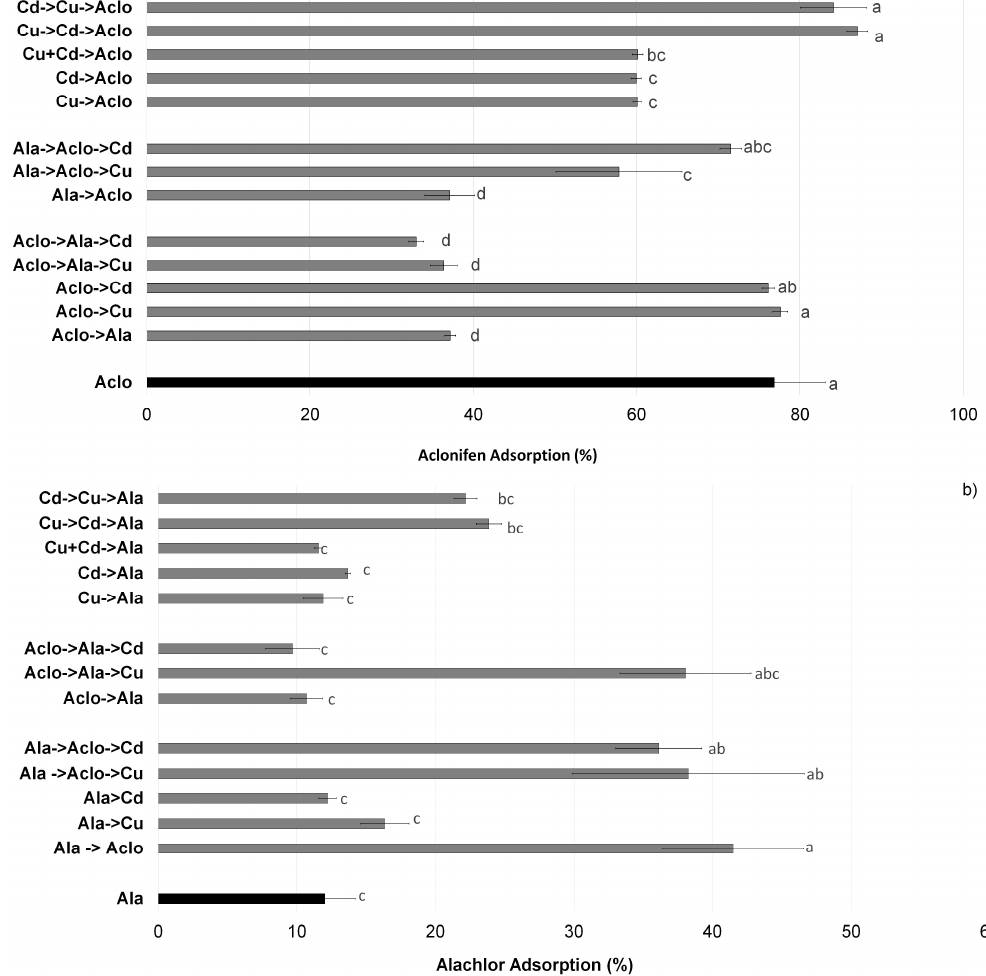
Figure 6. Average percentage of Aclonifen ( a ) and Alachlor ( b ) adsorbed on Suspended Matter in different multipollution scenarios. Means with the same letter (a, b, c, d) are not significantly different (ANOVA, p < 0.05).